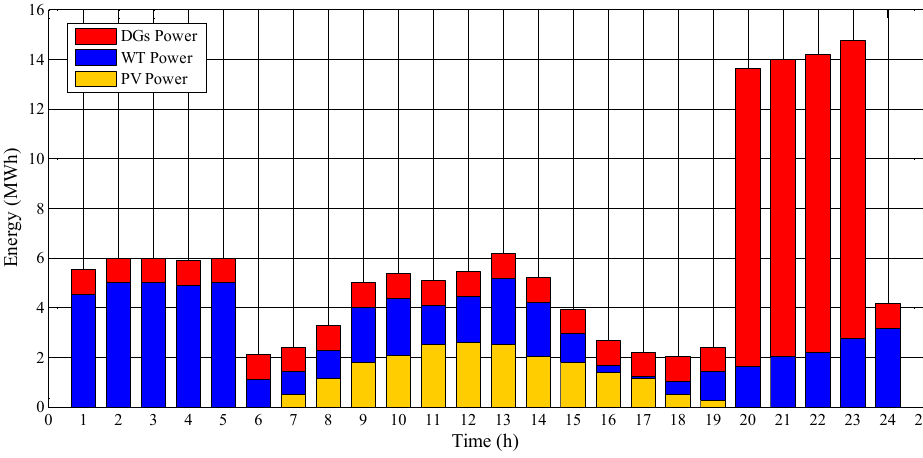
Figure 10. Optimal operating points of the DSO’s local units. Figure 11. Energies 2020 , 13 , x FOR PEER REVIEW